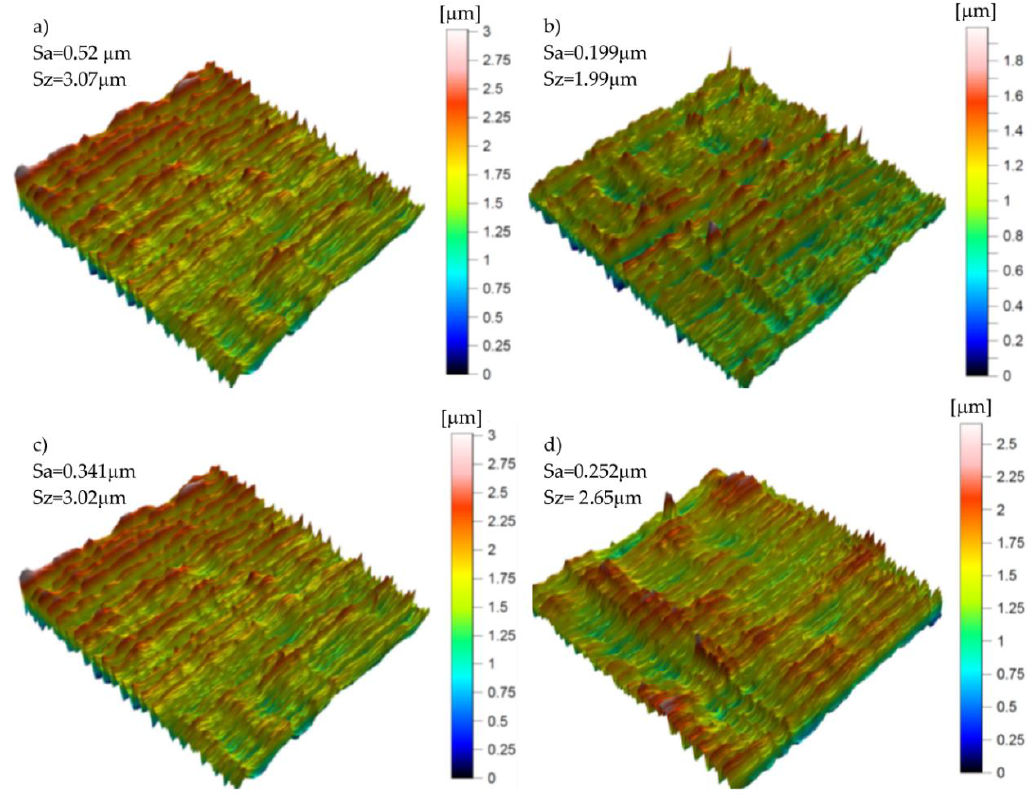
Figure 15. Graphs representing the isometric view of the surface topography in the points: ( a ) B; ( b ) D; ( c ) E; ( d ) G.